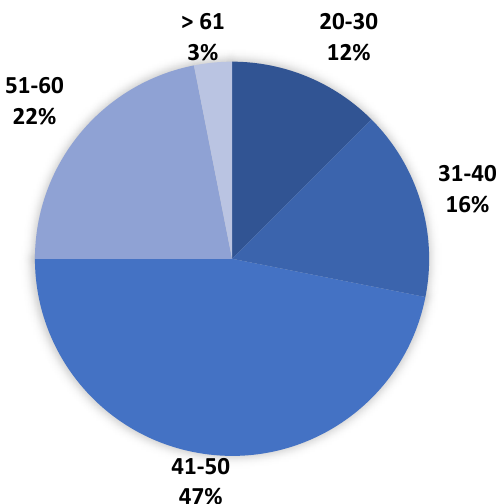
Figure 1. Age distribution.